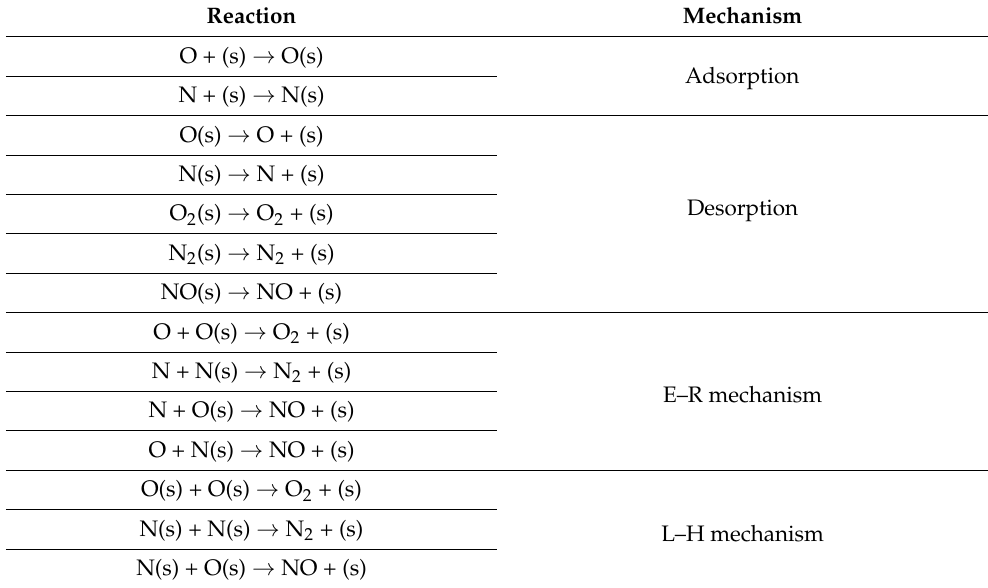
Table 2. Surface reaction